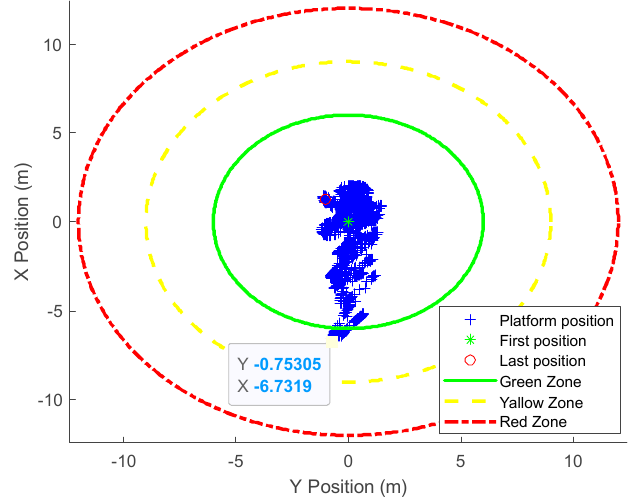
Figure 14. DP simulation with PID control showing platform position (Head sea).